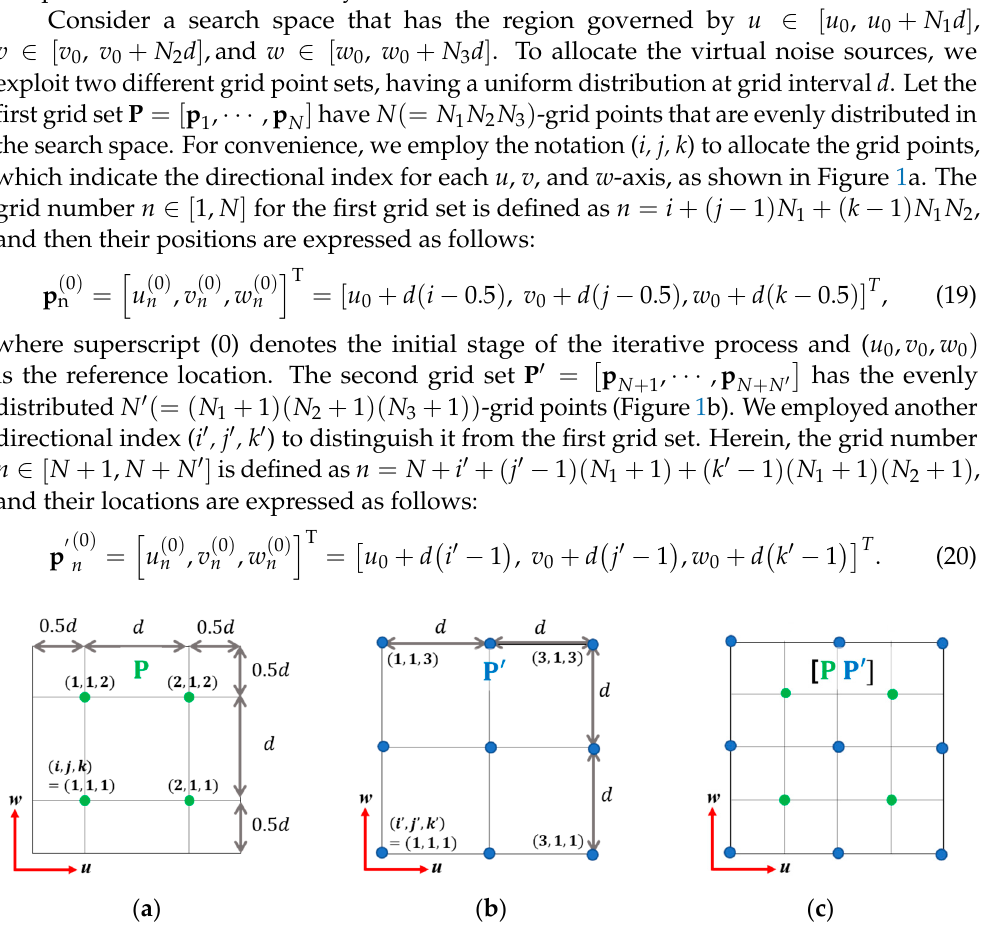
Figure 1. Two different grid sets and corresponding pairwise grid set projected on the u–w plane. ( a ) Distribution of the first grid set P ; ( i, j, k ) represent the directional index of the first grid set for each u , v , and w -axis, respectively. ( b ) Distribution of the second grid set P ’; ( i’, j’, k’ ) represent the directional index of the second grid set for each u , v , and w -axis, respectively. ( c ) Pairwise grid set [ P P ’] in the search space comprising the first and second grid set.